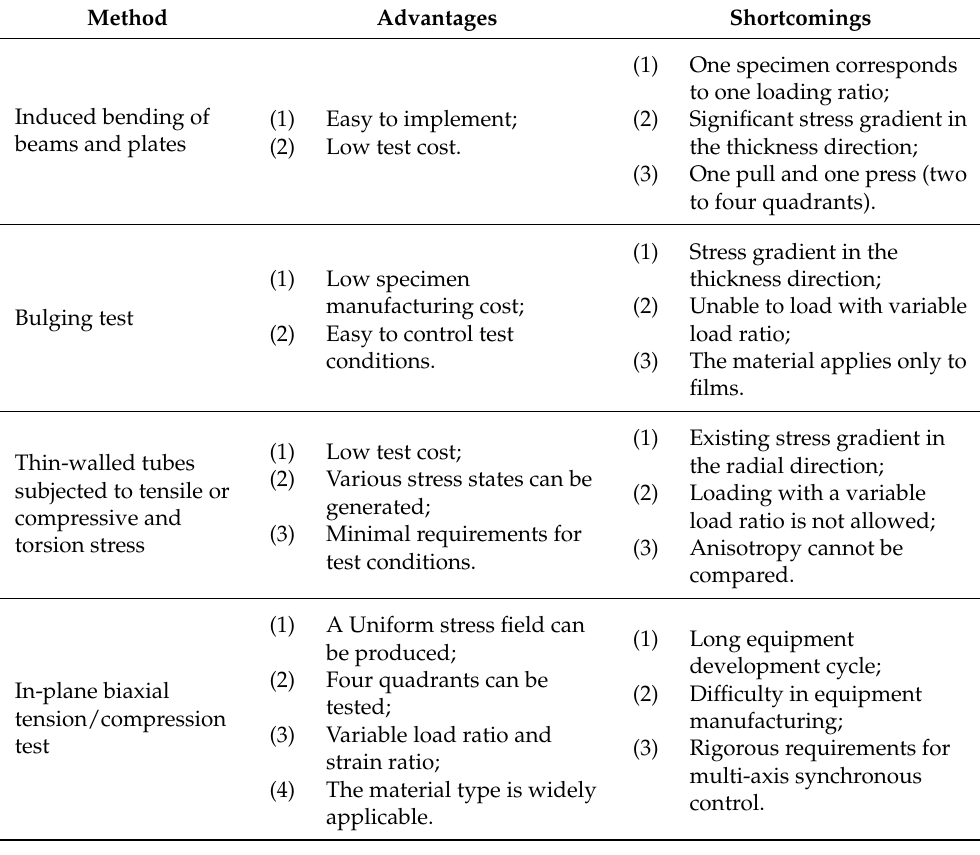
Table 1. Advantages and disadvantages of four methods for generating biaxial